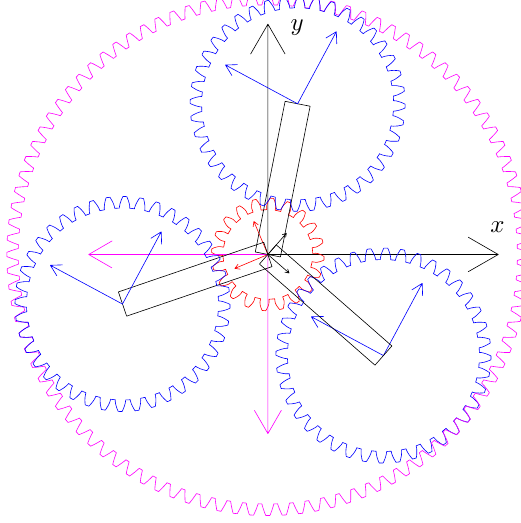
Figure 8: Illustration generated by Matlab implemen- tation (both rigid and (cid:29)exible